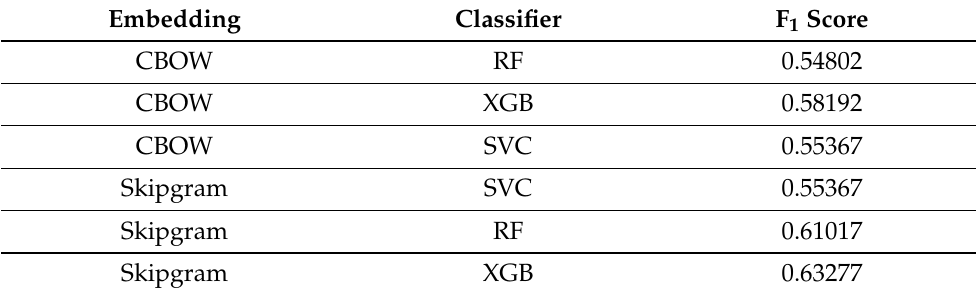
Table 5. Embeddings: Custom CBOW, Skipgram, Word2Vec (trained by our group). Features: